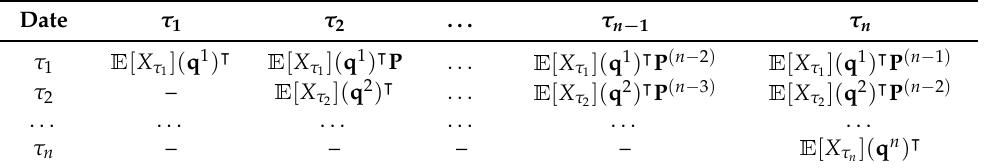
Table 1. Accounting of n Markov cohorts each with an initial